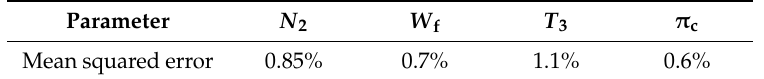
Table 5. Mean squared error of performance parameters in the engine population.